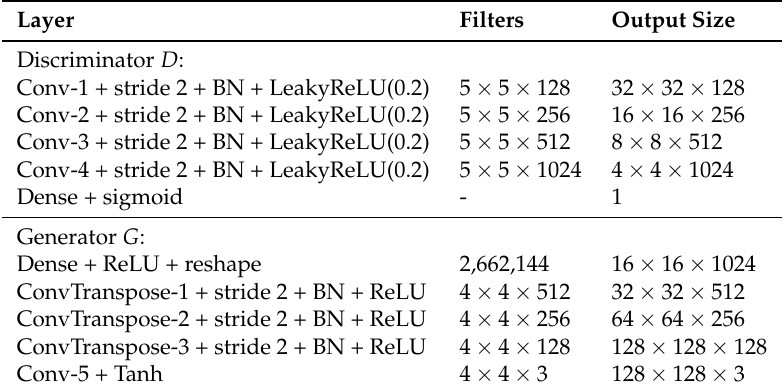
Table 1. Deep convolutional GAN (DCGAN)